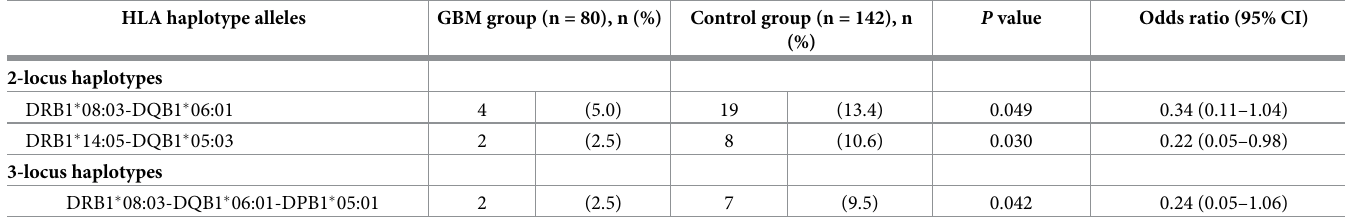
P value Odds ratio (95% CI) (%)